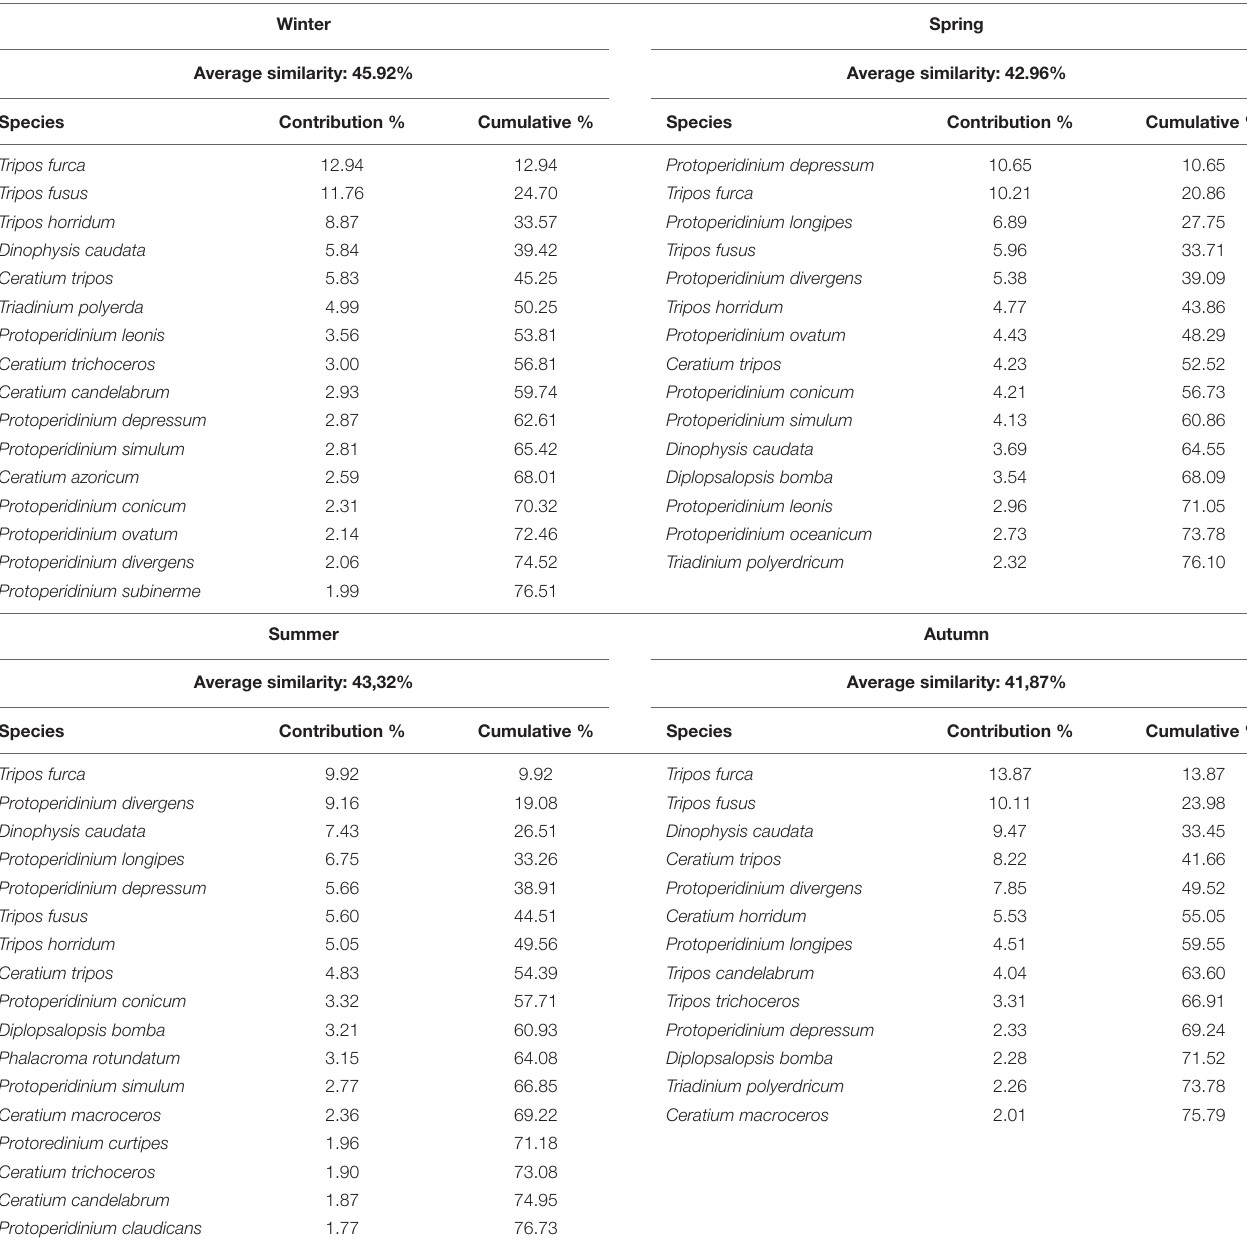
TABLE 4 | Contribution of species to the similarities between seasonally grouped samples obtained by SIMPER analysis applied to standardized log transformed data for species proportions. Winter